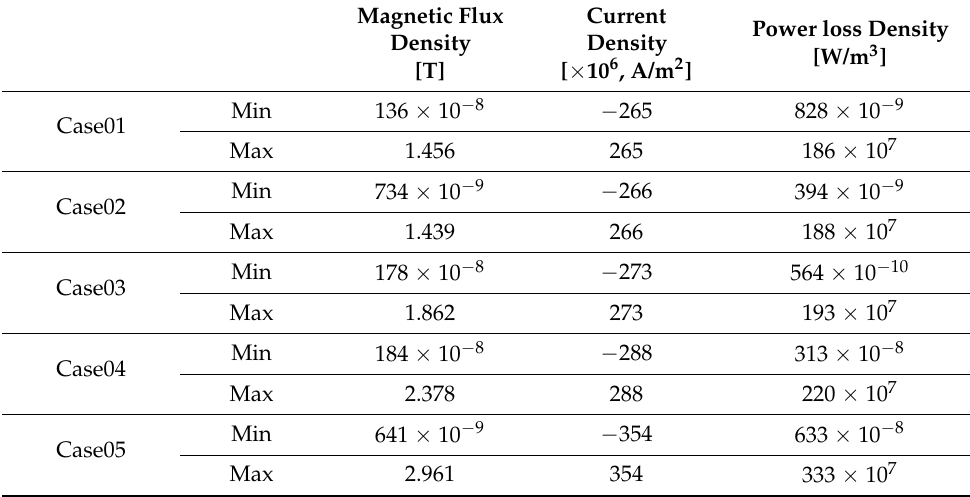
Table 8. Analysis results of normal direction